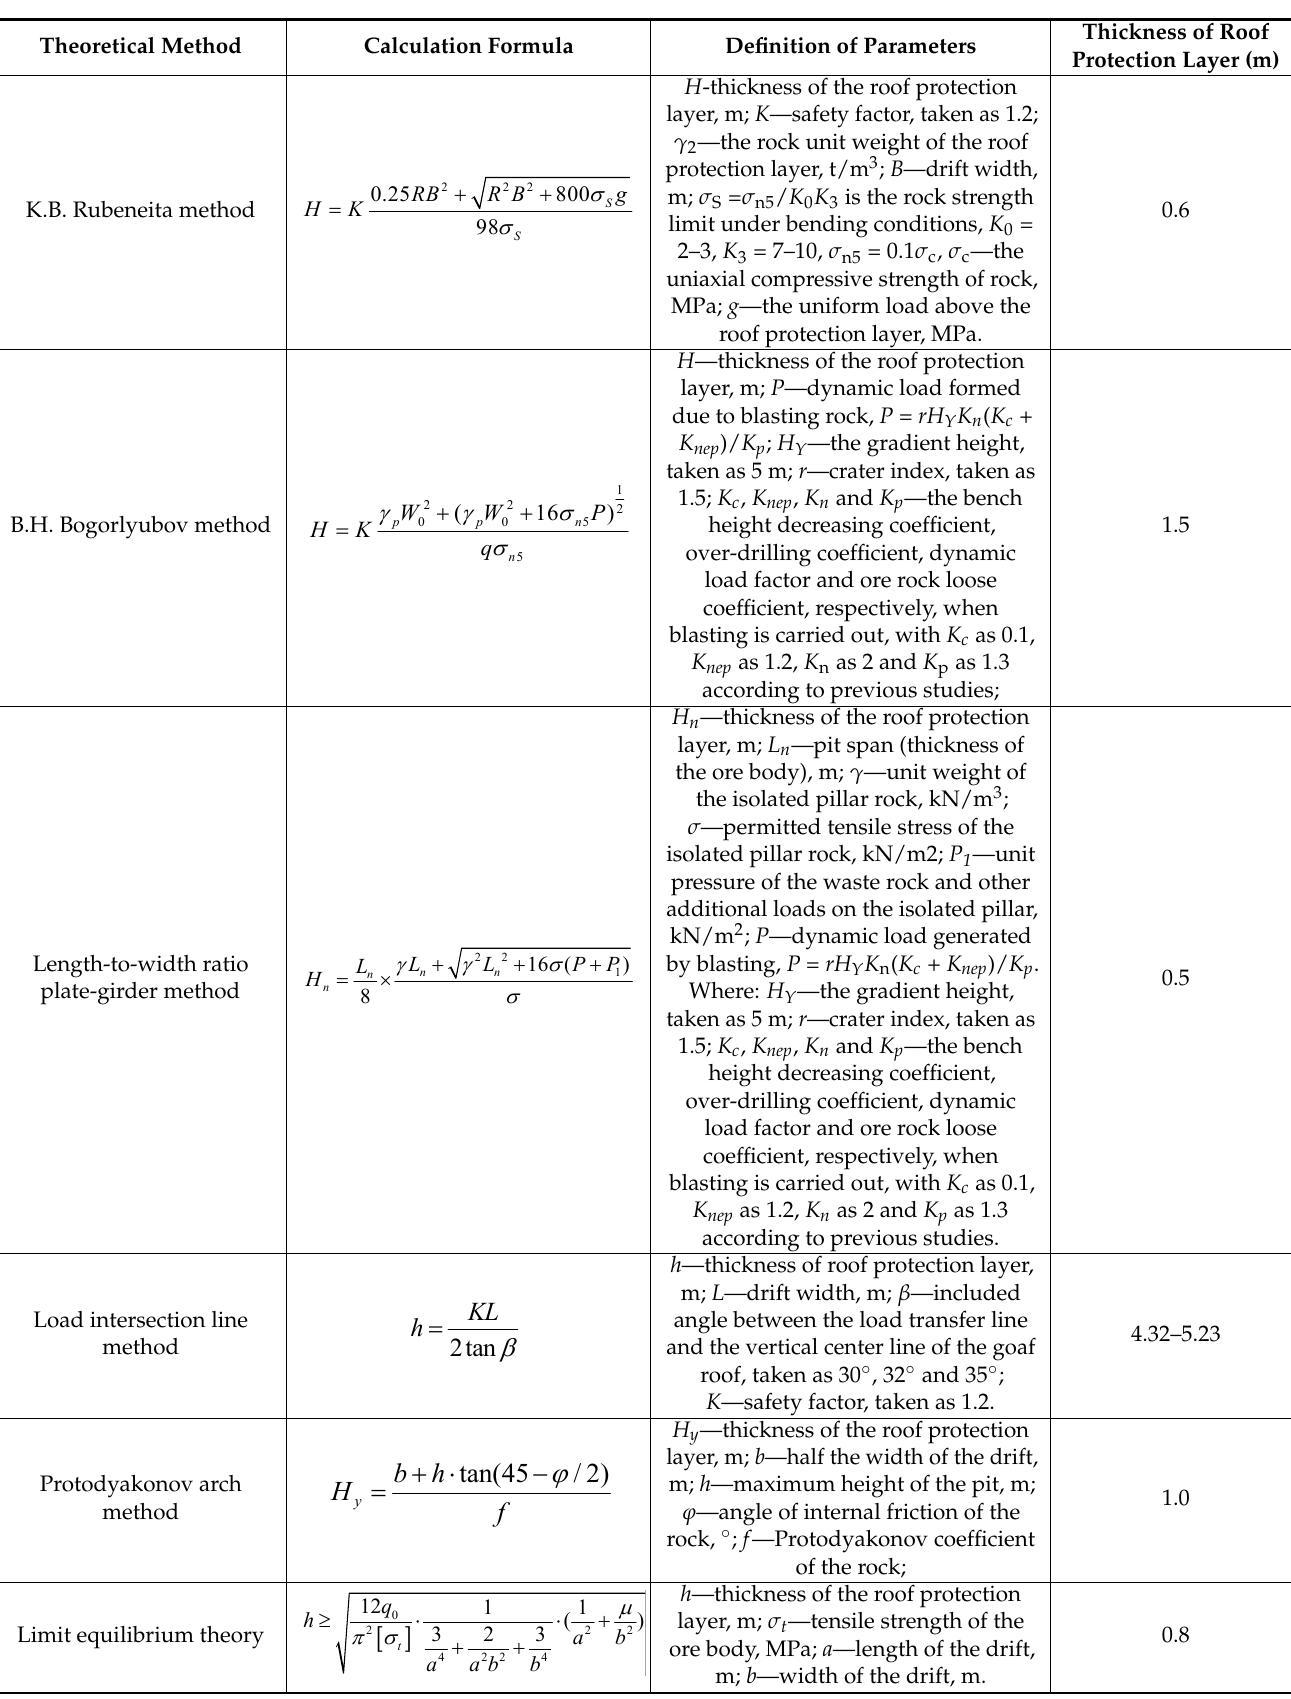
Table 2. Theoretical calculation methods and results. Table 2. Cont .